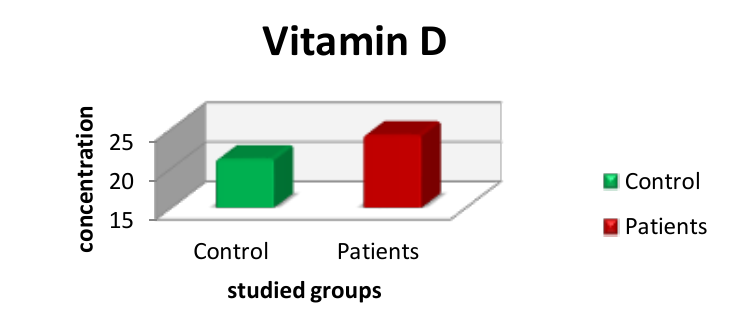
Figure 2: Levels of vitamin D in patients and control